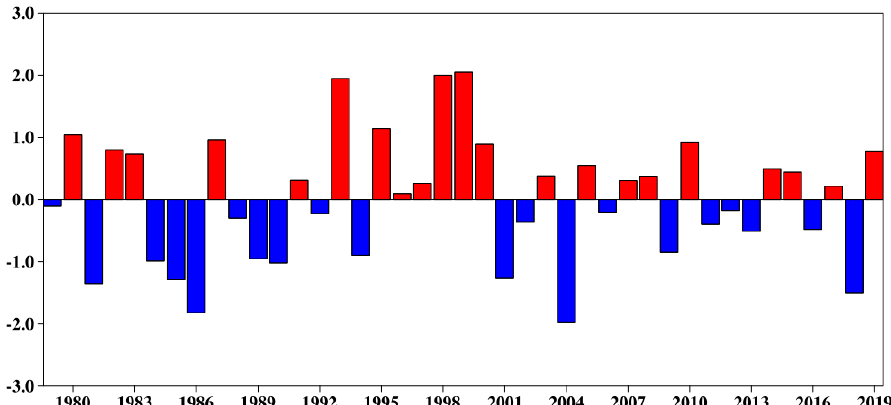
Figure 5. Histogram of East Asian subtropical monsoon surge index in 1979 – 2019 ((the ordinate is the normalized value of the East Asian subtropical monsoon surge index).